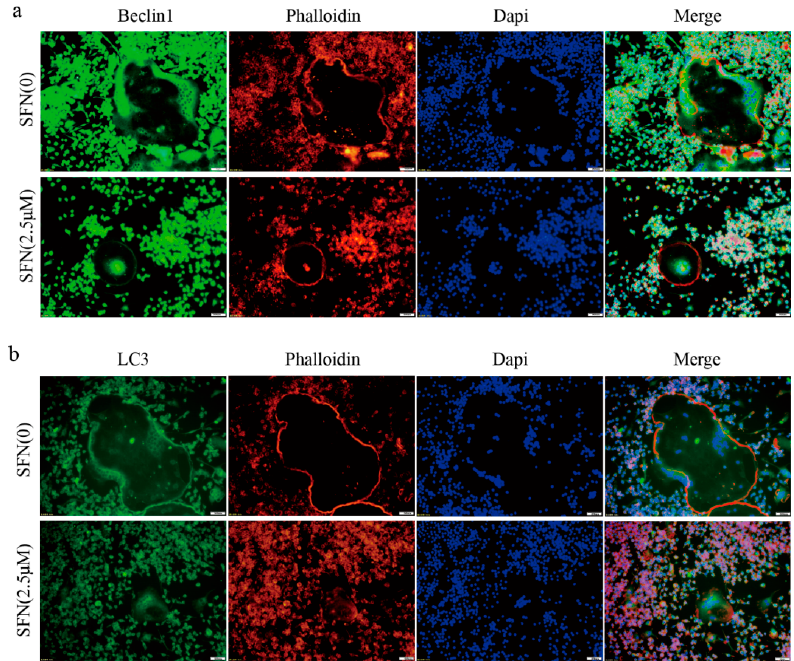
Figure 2. SFN inhibited the accumulation of autophagic light chain 3 (LC3) and Beclin1 within osteoclasts. RAW264.7 cells were induced by 50 ng/mL of RANKL for 5 days, and immunofluorescence (IF) analysis was performed. ( a ) Representative IF images locating LC3 (green) within the osteoclasts. ( b ) Representative IF images locating Beclin1 (green) within the osteoclasts. F-actin was stained with phalloidin (red). DAPI (blue) was used to visualize the